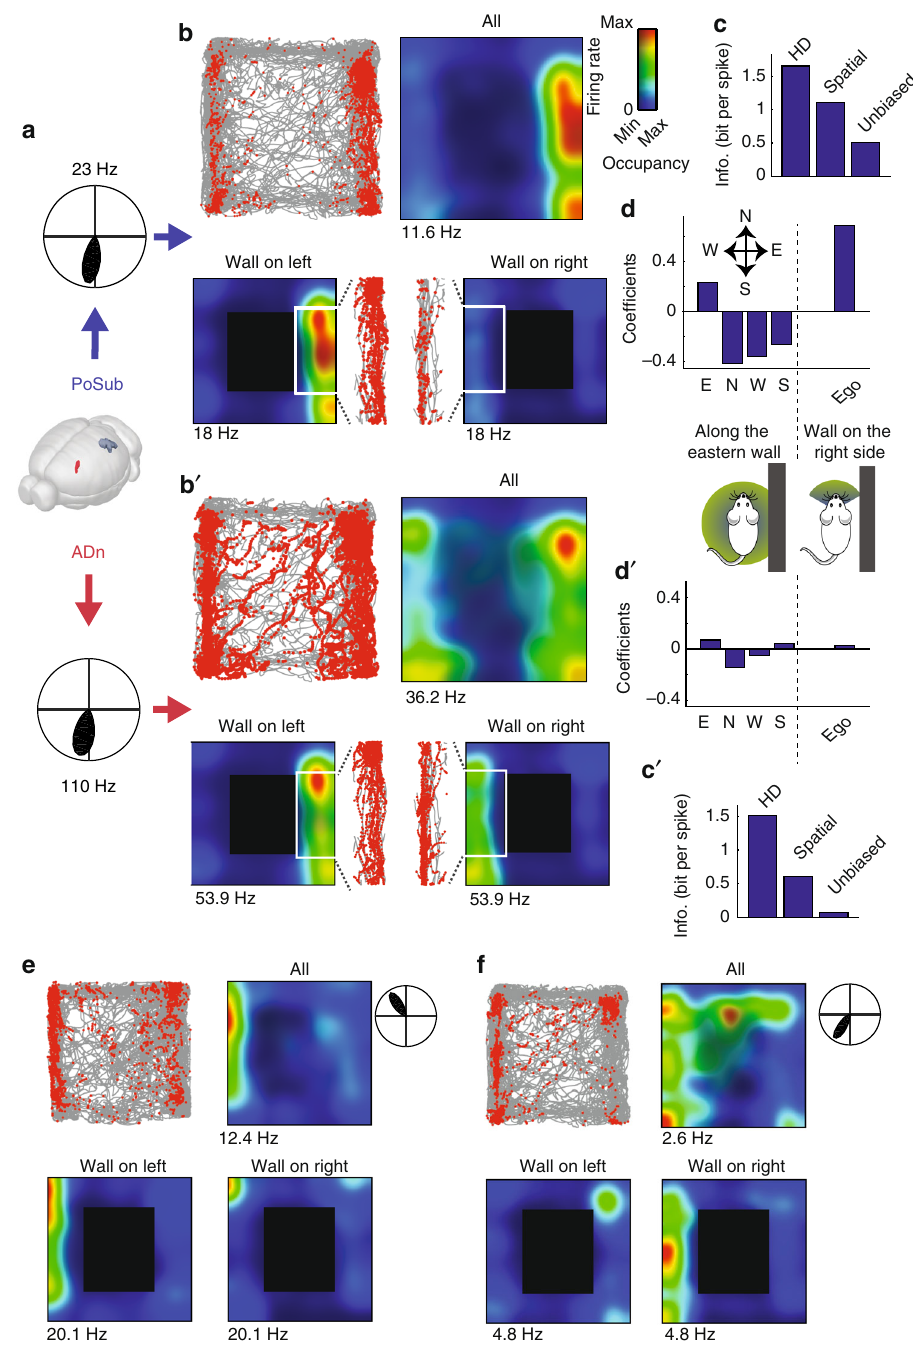
Fig. 1 Spatial correlates of example HD neurons. a Two example HD neurons recorded simultaneously in the PoSub (top) and in the ADn (bottom). Polar plots indicate average fi ring rate in function of animal ’ s orientation. b Top left: position of the animal (gray) superimposed with location of the animal when the neuron spiked (red dots); top right, spatial tuning of the neuron where average fi ring rate at each location is represented as a colormap. Contrast displays the overall occupancy at each location. Bottom, place fi elds of the neuron during exploration along the borders when the walls are located on the left of the animal (left panel) or on the right (right panel). Inset show animal ’ s position and spike location in the two con fi guration during which a neuron governed only by its HD tuning curve is expected to fi re. c HD, spatial and unbiased information per spike of the neuron shown in a (see Methods and Supplementary Fig. 1). d Top, regression coef fi cients of the generalized linear model applied to the binned spike train of the neuron displayed in a , consisting of walls (East, North, West or South) or relative wall position (Ego), both regression included expected instantaneous fi ring rate from HD tuning curve (see Supplementary Fig. 4). Bottom, schemas depicting the two types of behavioral variables used to regress the neuronal data on: left, speci fi c border sensitivity (East, North, West or South) independently of animal ’ s head-direction; right, animal ’ s position relative to the closest wall ( ‘ all on the right ’ or ‘ wall on the left ’ ) within a ± 60° range of head direction. b ′ – d ′ Same as b – d for a ADn HD neuron. e – f Additional examples of two wall-modulated HD neurons in the PoSub. Brain displayed in a © 2015 Allen Institute for Brain Science. Brain Explorer.